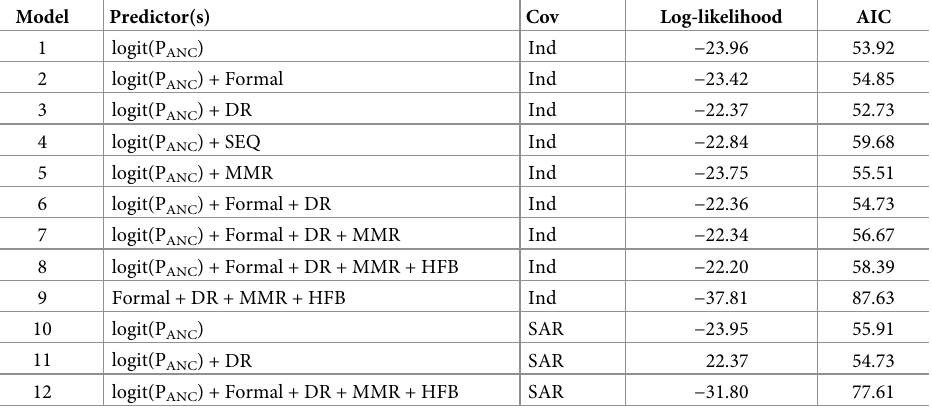
Table 1. Model comparison based on the log-likelihood and Akaike Information Criterion (AIC; smaller is better). P ANC denotes the HIV prevalence proportion among pregnant women obtained from surveillance at antenatal care (ANC) clinics. Other auxiliary predictors are: Formal = formal dwellings (%); DR = dependency ratio; SEQ = socio- economic quintile; MMR = maternal mortality rate; HFB = births in health-care facilities (%). Covariance structures (Cov) are independence (Ind) or simultaneously autoregressive (SAR).